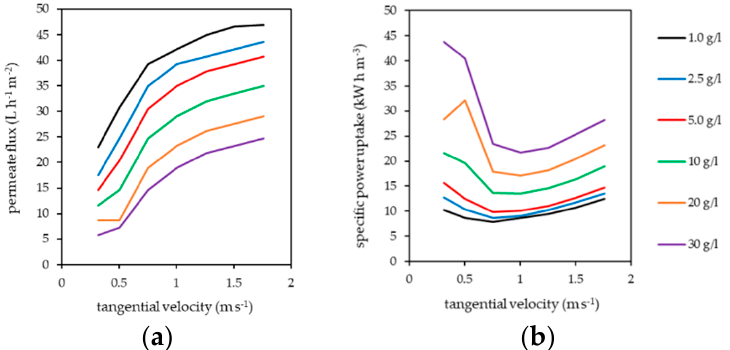
Figure 4. Influence of tangential velocity and polymer concentration on ( a ) permeate flux and ( b ) specific power consumption (pressure and cross-flow pump) of the pilot plant. HB-PEI diluted in fly ash extract. Transmembrane pressure (TMP) = 5 bar, T = 40 °C.